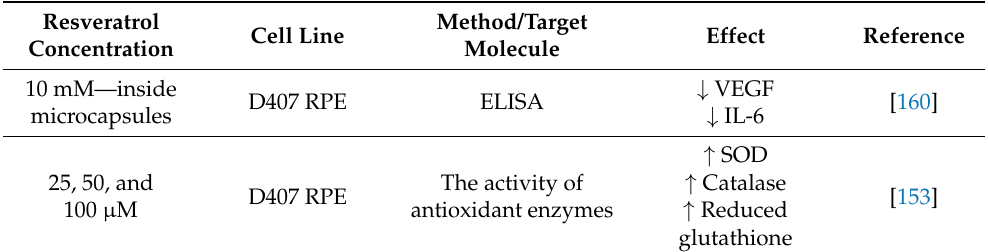
Table 2. Experiments performed on retinal cell lines aiming to investigate the potential therapeutic effect of resveratrol in different doses